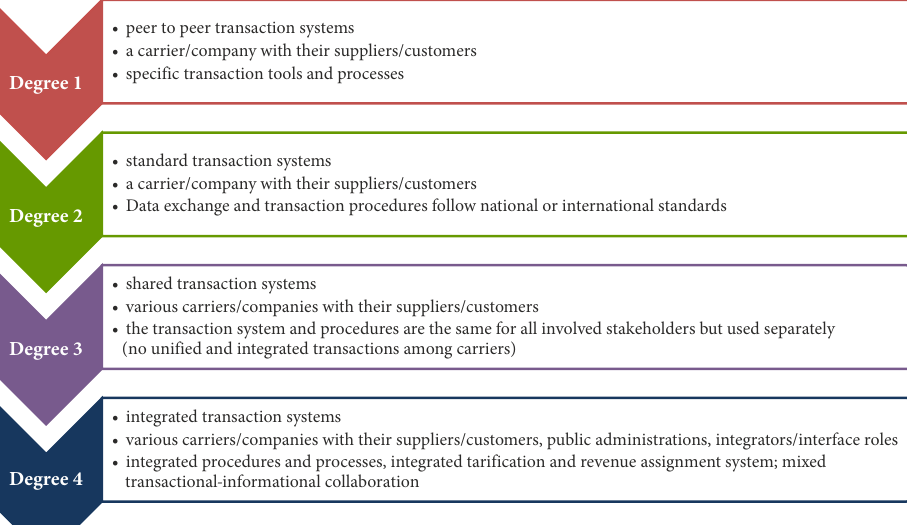
Figure3. The different degrees of maturity in transactional collaboration